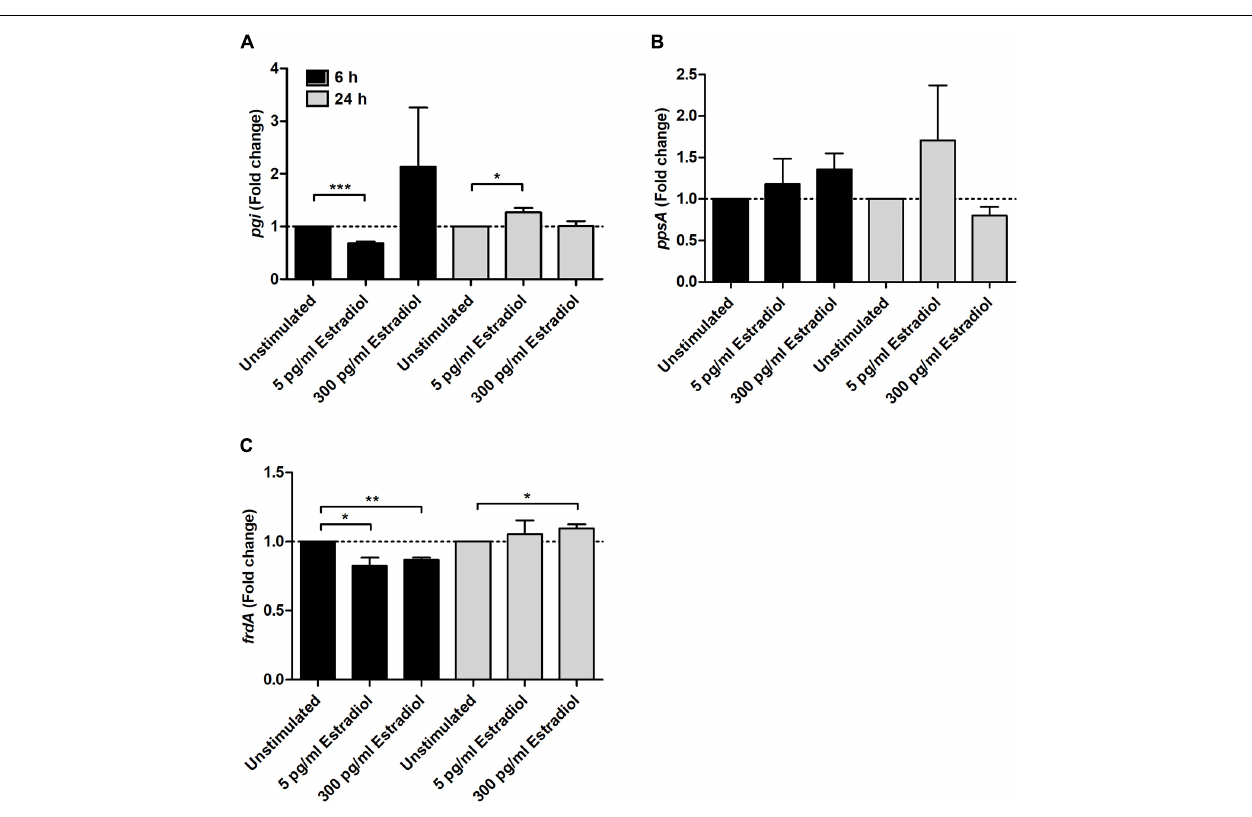
FIGURE 3 | Real-time qPCR analysis of pgi (A) , ppsA (B) , and frdA (C) gene expression in the presence or absence of estradiol (5 and 300 pg/ml) at 6 and 24 h. Data are presented as mean ± SEM of n = 3 independent experiments. The asterisks distinguish statistical significance: * p < 0.05; ** p < 0.01; *** p < 0.001 vs. unstimulated